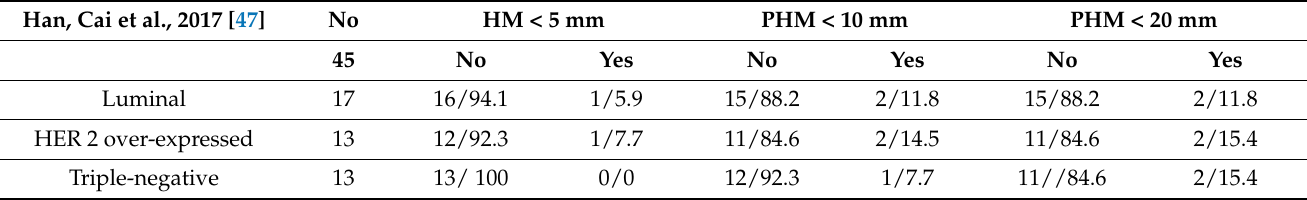
Table 5. The incidence of hippocampal and perihippocampal metastases in breast cancer patients. Incidence of Brain Metastases Study, Year No HMs PHMs No (%) No (%) Wu, Sun et al., 2016 [43] 192 7 (3.6%) 14 (7.3%) Witt, Pluard et al., 2014 [44] 73 6.8% 15% Sun, Huang et al., 2016 [45] 314 2 (4.1%) 5 (11.1%) Wu, Rao et al., 2015 [46] 56 4.1% 5.5%